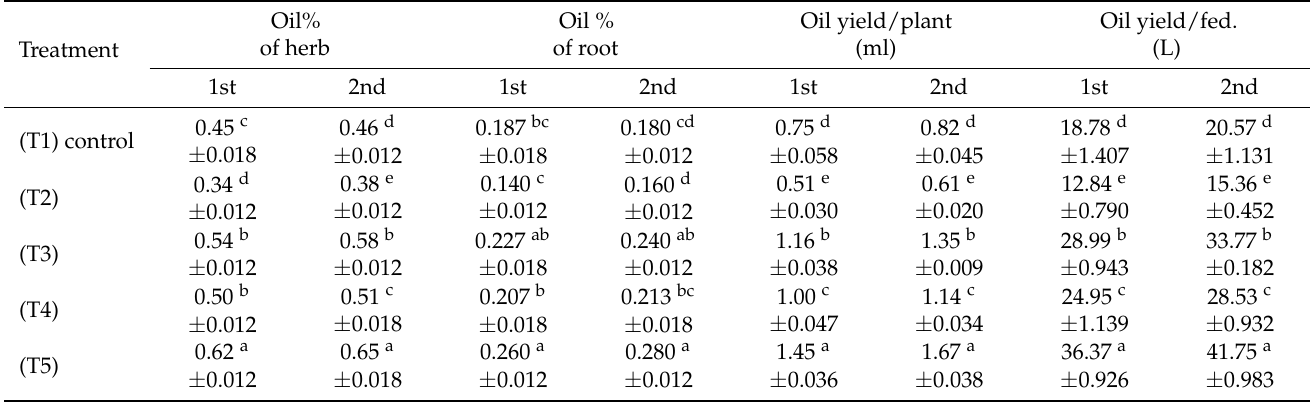
Table 7. Essential oil (EO) productivity under drought conditions and different nanoparticle applica- tions on Solidago canadensis plants during the 2020 and 2021 growing